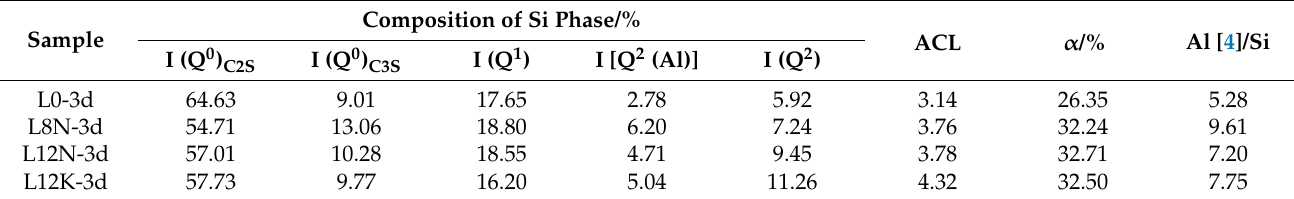
Table 6. Composition of Si phase in cement pastes with different contents and types of alkali sulfates at 3 d. Composition of Si Sample